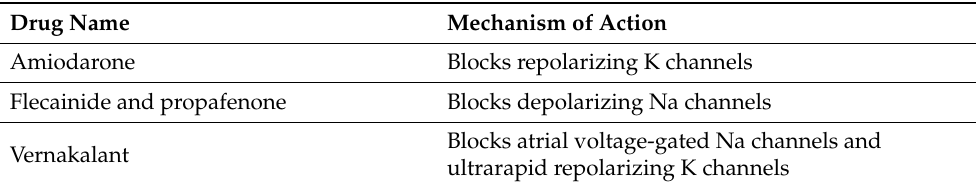
Table 1. Mechanism of action for rhythm control drugs used for new-onset